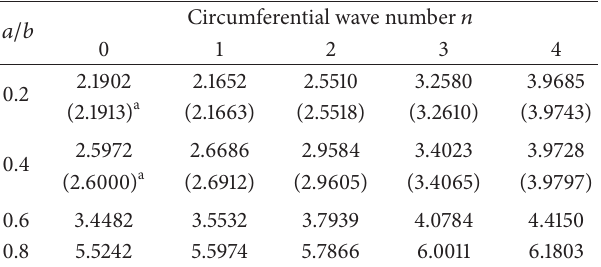
Table 10: Frequency parameters, Ω = 𝜔𝑏(𝜌(1 − V 2 )/𝐸) 1/2 , for an annular plate with identical restraints at all edges: K = 10 9 N/m 2